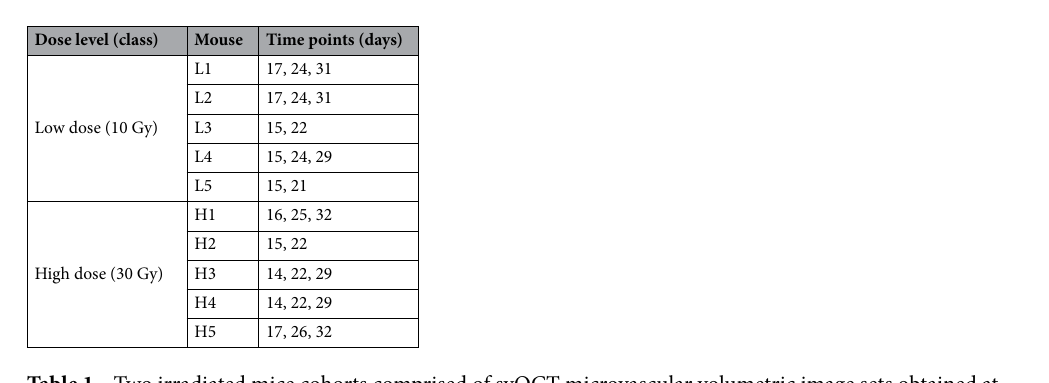
Table 1. Two irradiated mice cohorts comprised of svOCT microvascular volumetric image sets obtained at time t = 2–4 weeks following irradiation.